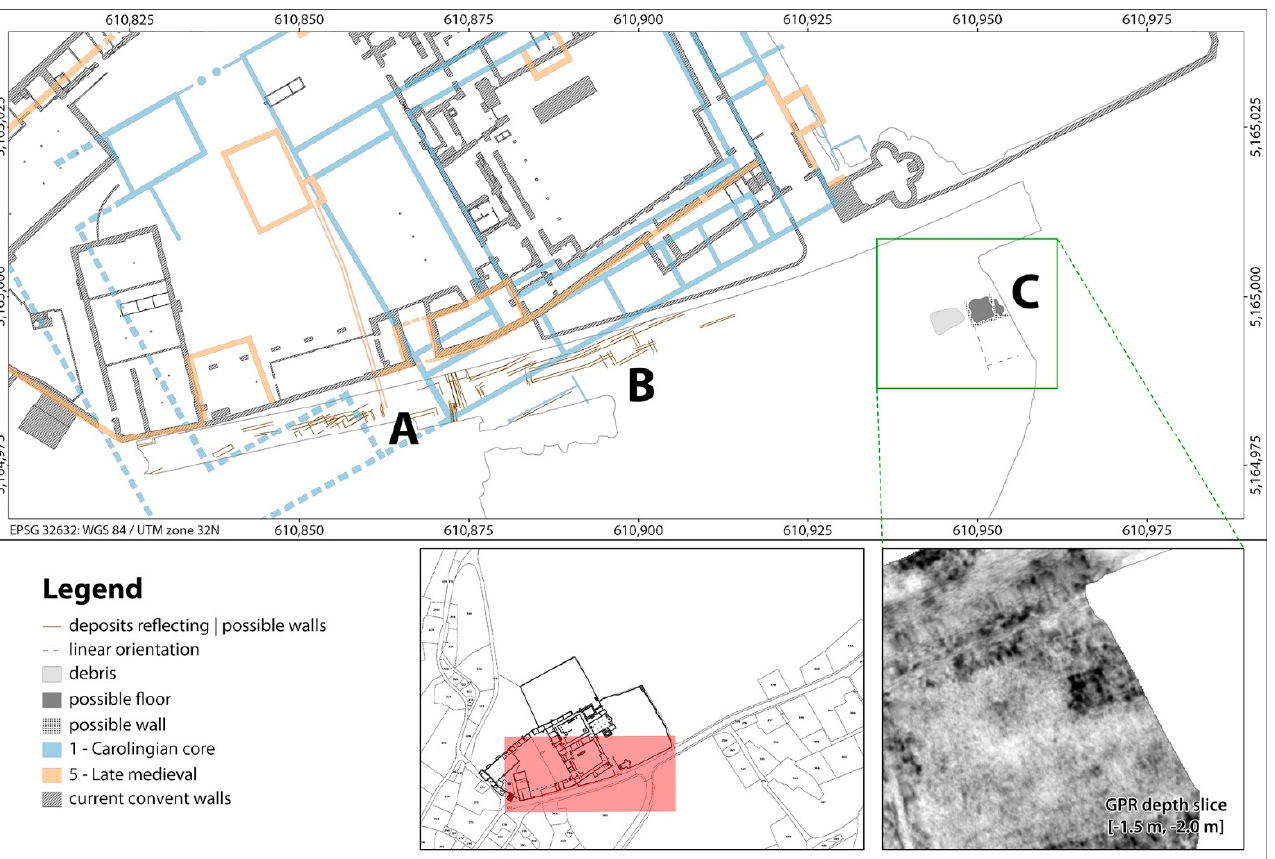
Figure 7. Overview of the known historical structures and the prospection additions in area 3 (see the text for A, B , and C ).